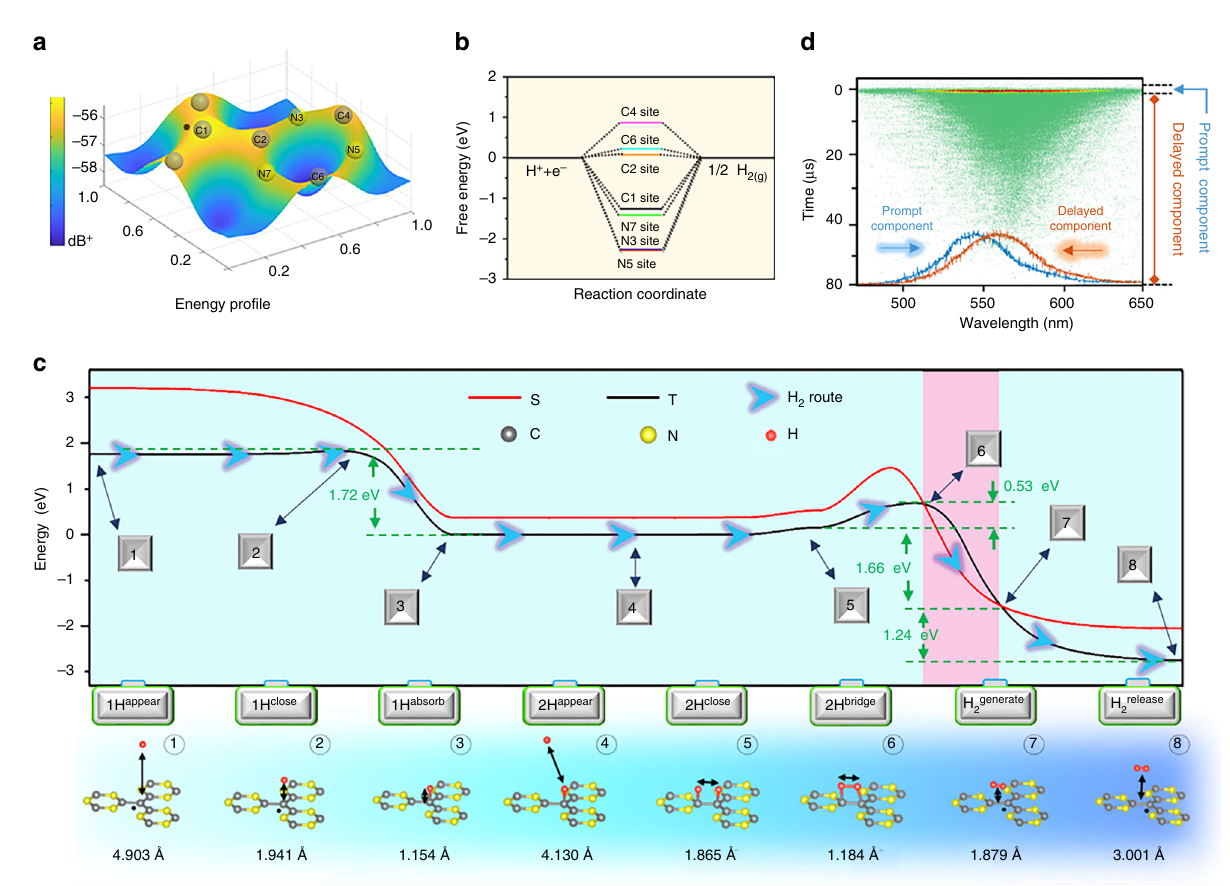
Fig. 6 Schematic con fi guration-coordinate diagrams for HER mechanism. a The potential energy pro fi le for the adsorption of H + on the different sites. b The process of hydrogen production. c Free energy versus the reaction coordinates of HER for different active sites. The singlet (red), triplet (black), and optimal process (marked by a black arrow) as function of the H atom distance are displayed for comparison. The accompanying atom con fi gures are shown in lower plane. d Streak image and photoluminescence spectra of R@hm-C(CN) 3 nanosheets at 298 are Planck ’ s constant, the spin-orbit matrix element, slopes at energy crossing point between triplet and singlet states, respec- tively. By using V = 122 cm − 1 for describing H 2 dynamic process, we fi nd Pts = 0.78 at 300 K 28 , which con fi rms that the triplet-to- singlet conversion plays an irreplaceable role in this HER mechanism.